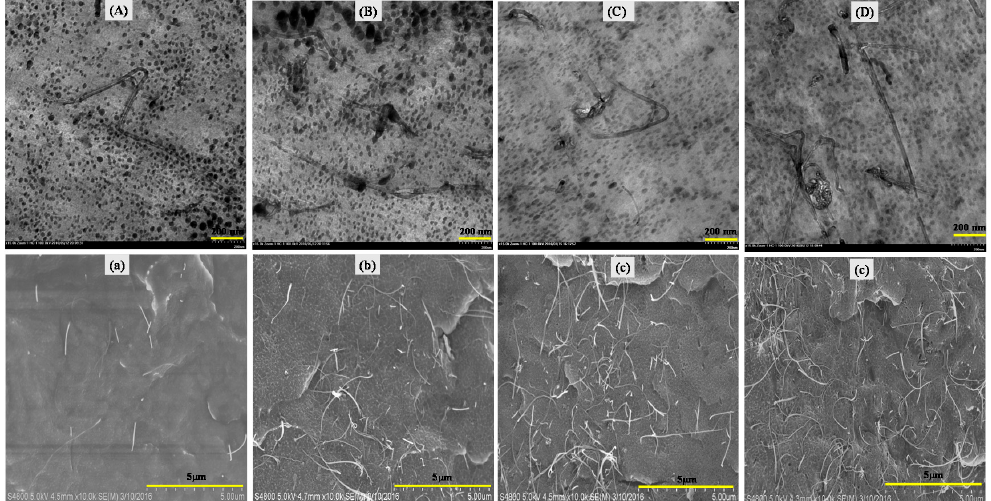
Figure 4. TEM and SEM images of nano-PVDF/IL-CNTs samples with various content of CNTs: ( A ) and ( a ): 100/10-0.1; ( B ) and ( b ): 100/10-0.5; ( C ) and ( c ): 100/10-1; ( D ) and ( d ) 100/10-2, respectively.